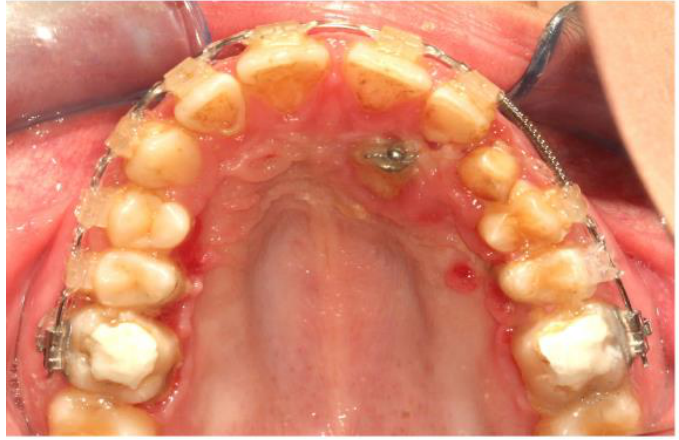
Figure 10. Right after the removal of the metal device. Notice the mild irritation of the palatal. mucosa (patient 1).